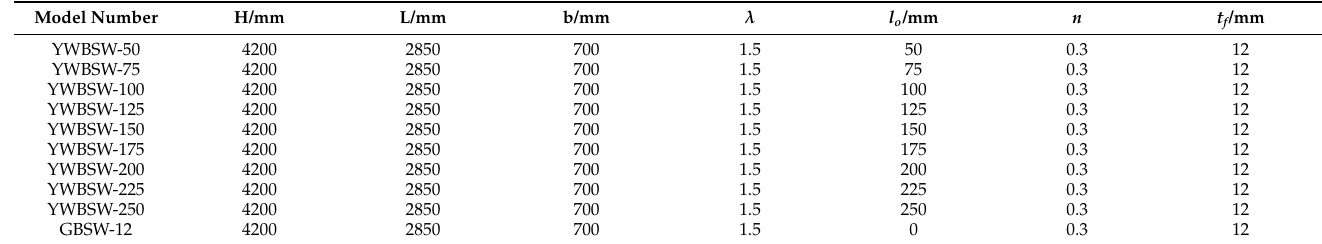
Table 8. Parameters of shear wall models with different lap